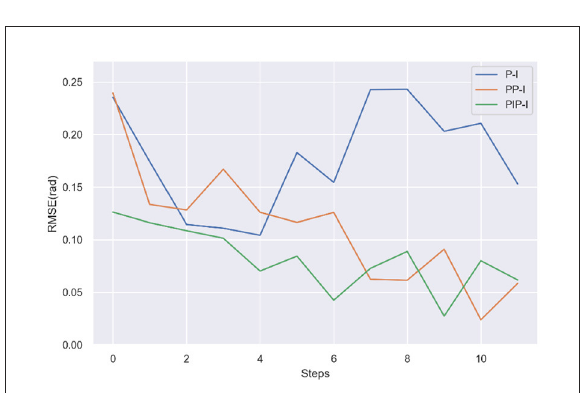
FIGURE10 Comparison of the RMSE of the mismatch error of three strategies, P-I, PP-I, and